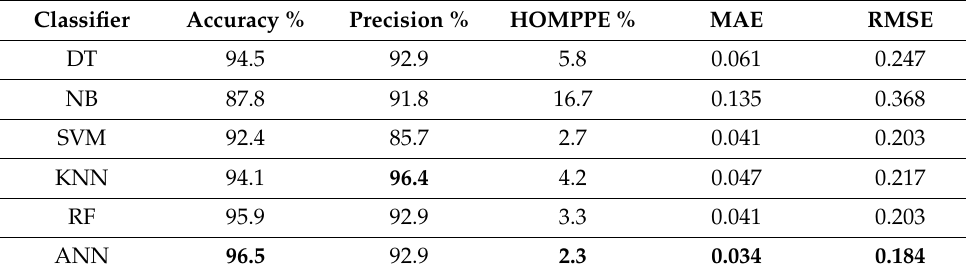
Table 5. Comparison of the prediction results of the proposed